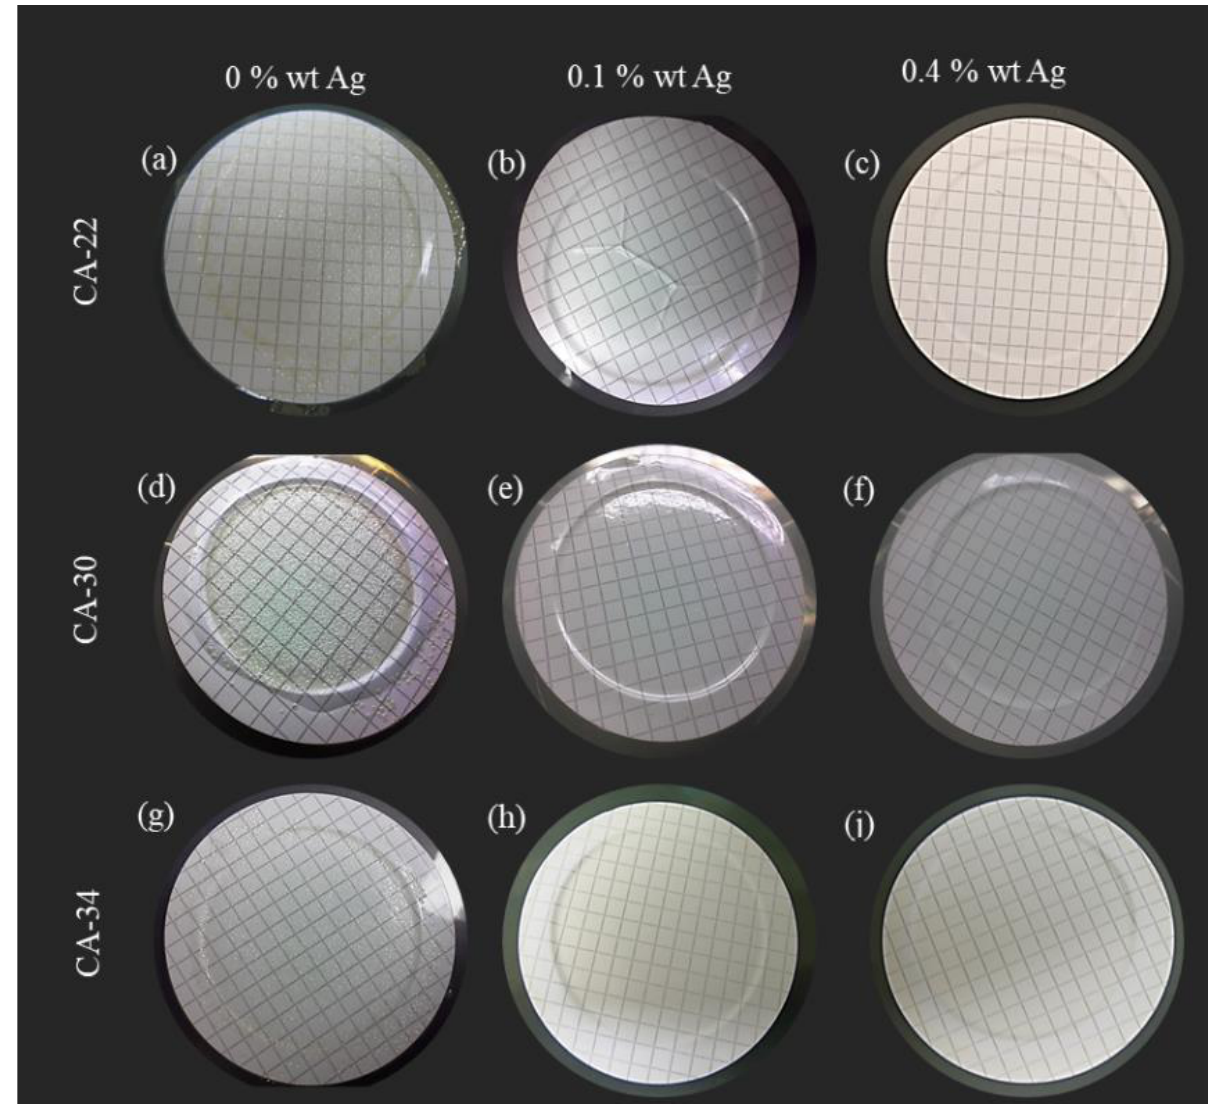
Figure 13. Results of E. coli growth inhibition on the suspension for the suspension test of CA and CA/Ag membranes. Silver-free membranes: ( a ) CA22, ( d ) CA30, and ( g ) CA34; CA/Ag membranes with 0.1%wt Ag: ( b ) CA22Ag0.1, ( e ) CA30Ag0.1, and ( h ) CA34Ag0.1; CA/Ag membranes with 0.4%wt Ag: ( c ) CA22Ag0.4, ( f ) CA30Ag0.4, and ( i )